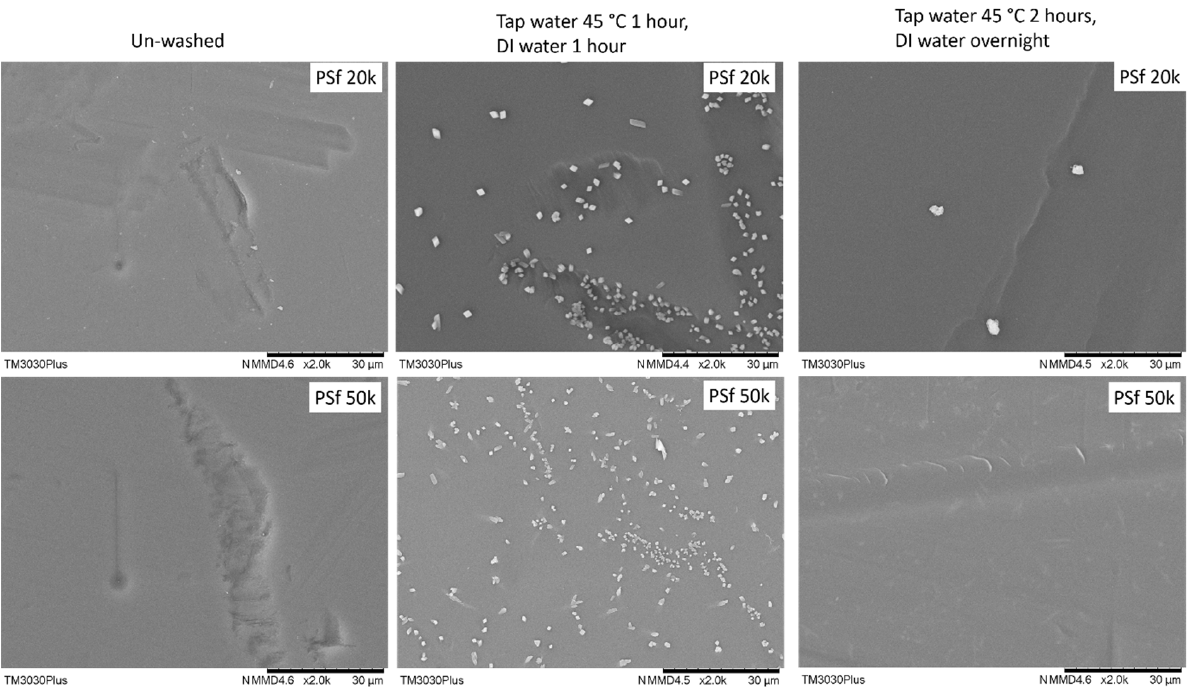
Figure 4. Surface morphology of 2 PSF porous supports washed by different procedures.